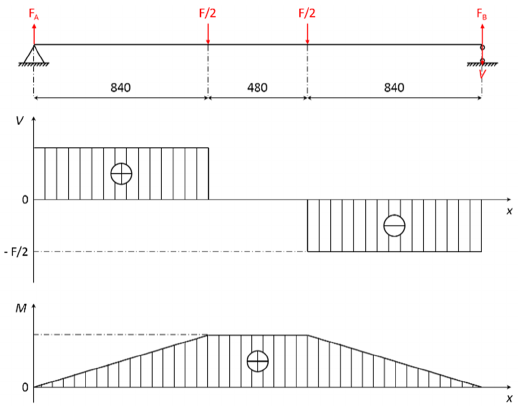
Figure 7. Shear diagram and bending moment diagram.